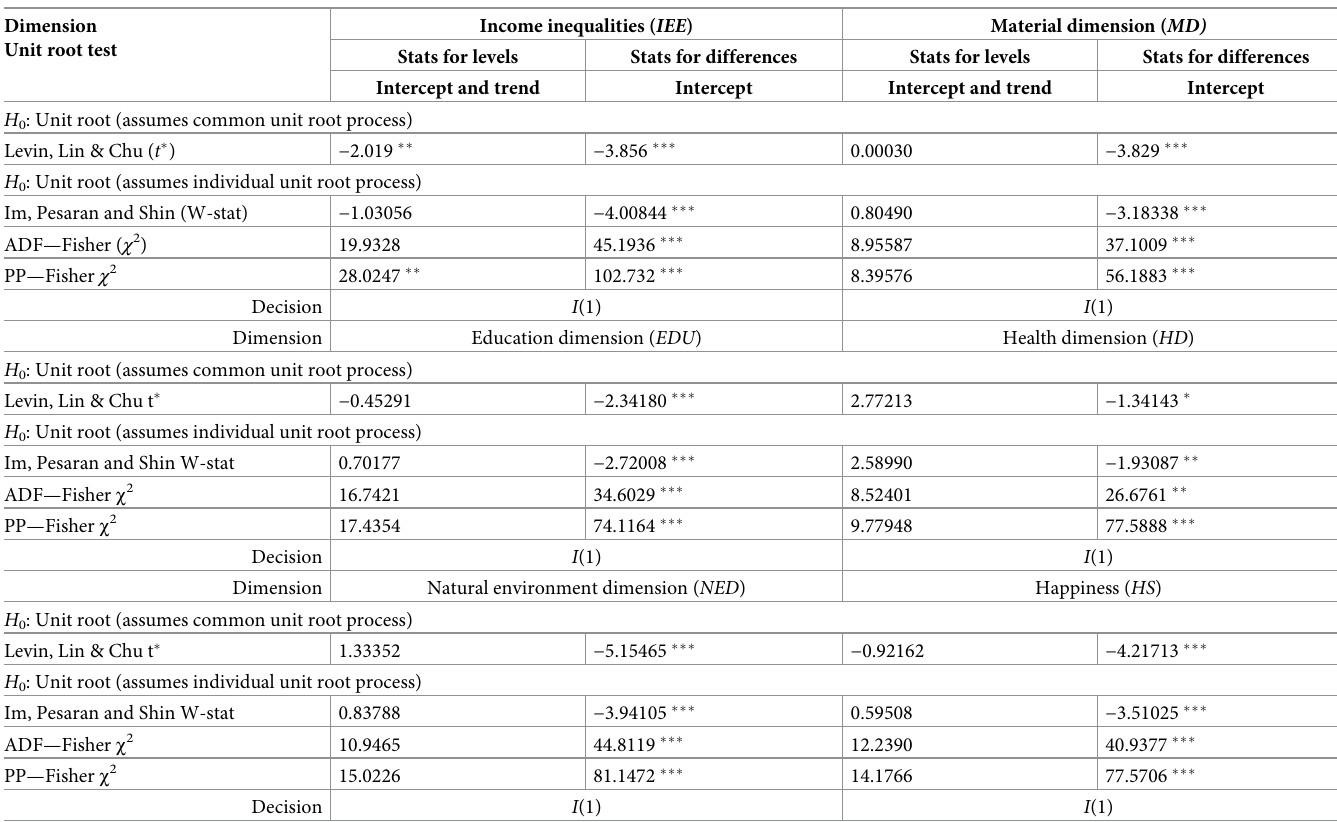
Table 2. Results of panel unit root test.